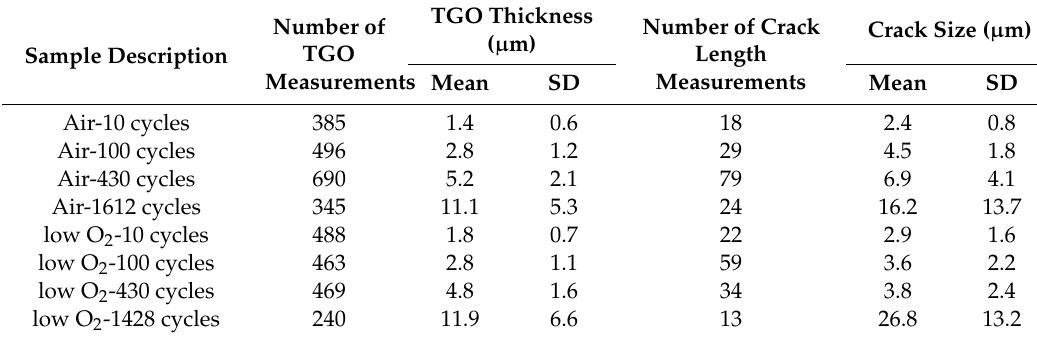
Table 1. Summary of TGO thickness and crack length measurements by PPT